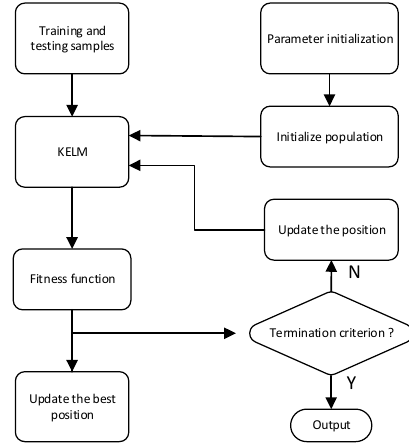
Figure 3. Computational procedure of QPSO for optimizing KELM.